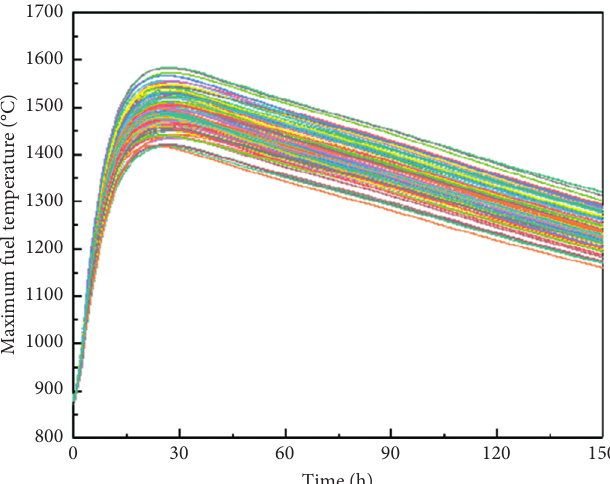
Figure 12: The time behavior of the maximum fuel temperature for the cases with normal distributed input